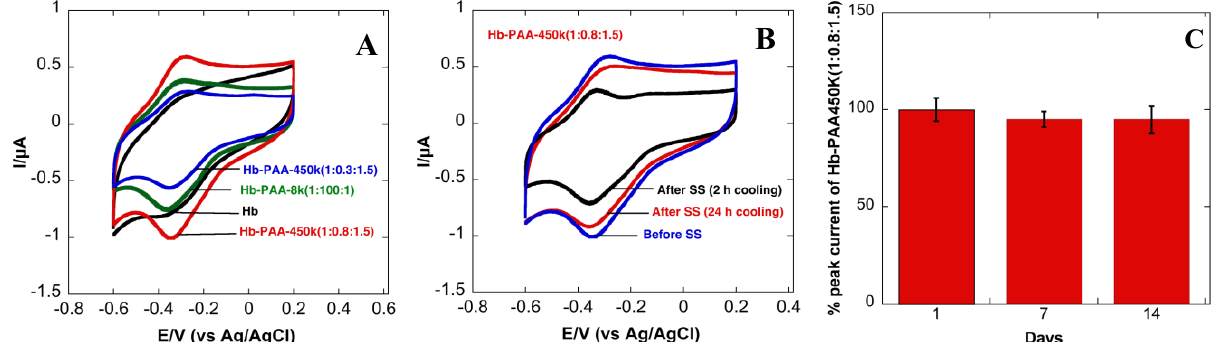
Figure 4. Improved stability: Cyclic voltammograms of Hb-PAA electrodes, ( A ) in pH 7.4 PBS (0.1 M) before heat treatment; ( B ) Hb-PAA-450k(1:0.8:1.5) electrode after steam sterilization (SS) with 2 h cooling (black) and 24 h cooling (red) in pH 7.4 PBS (0.1 M); ( C ) Stability of Hb-PAA-450k(1:0.8:1.5) electrodes at room temperature over 14